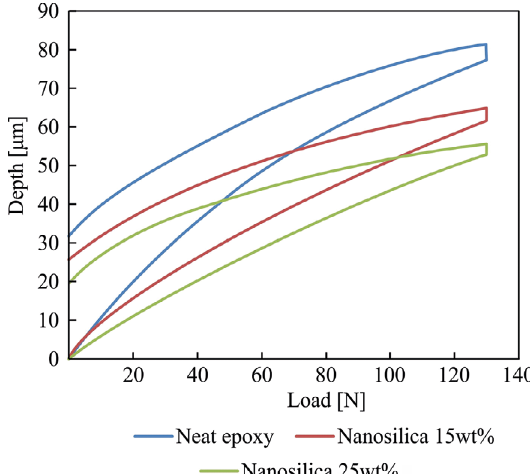
Figure 7. Typical load-depth profiles of neat epoxy resin and its